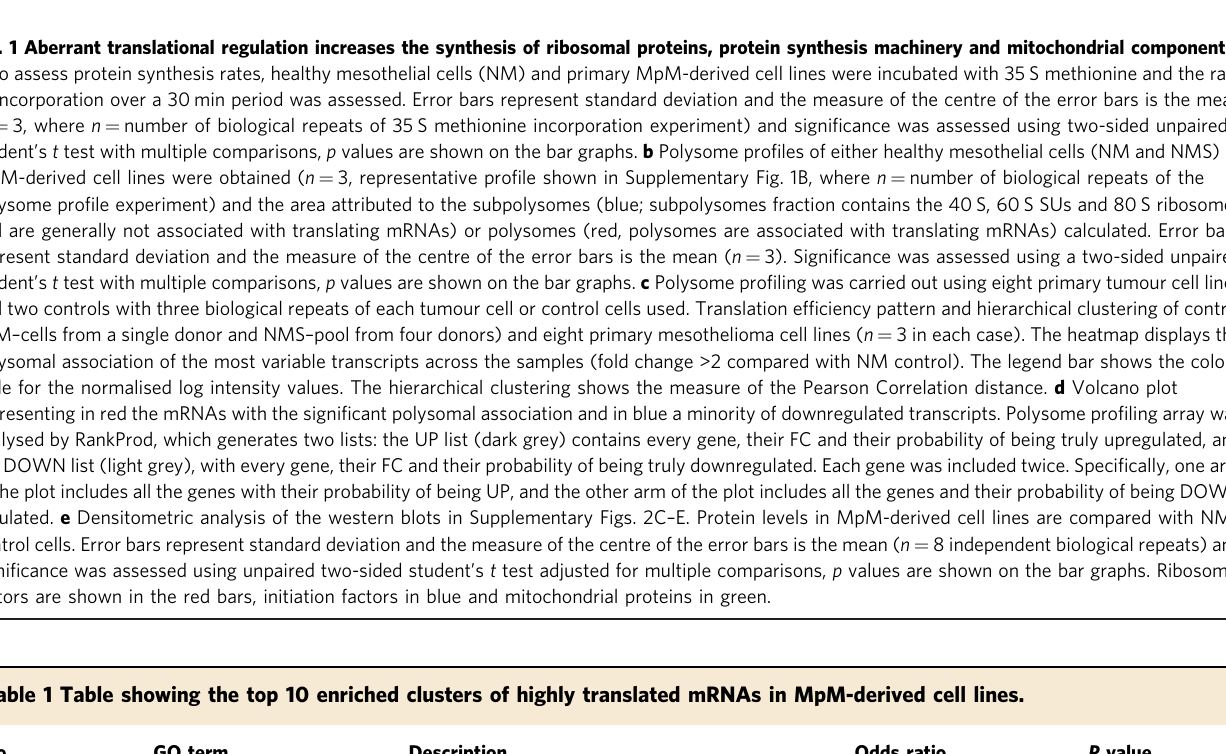
Table 1 Table showing the top 10 enriched clusters of highly translated mRNAs in MpM-derived cell lines. No.